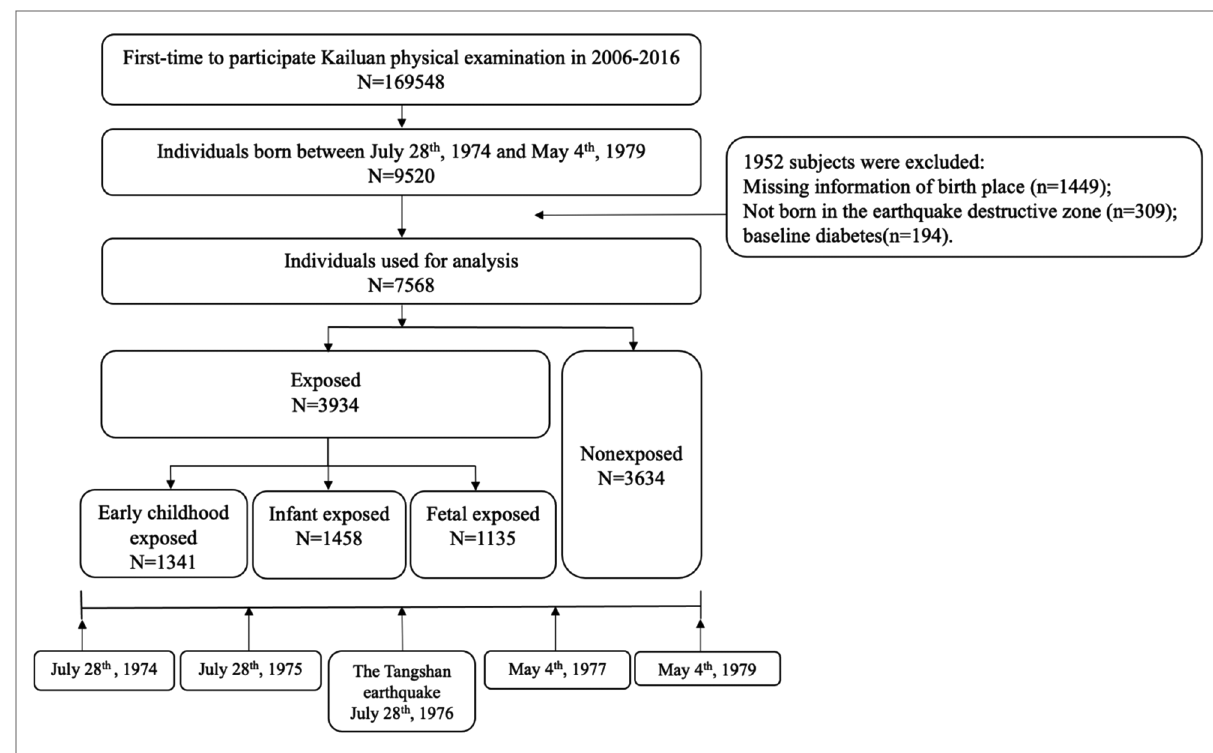
FIGURE 1 Flowchart of samples